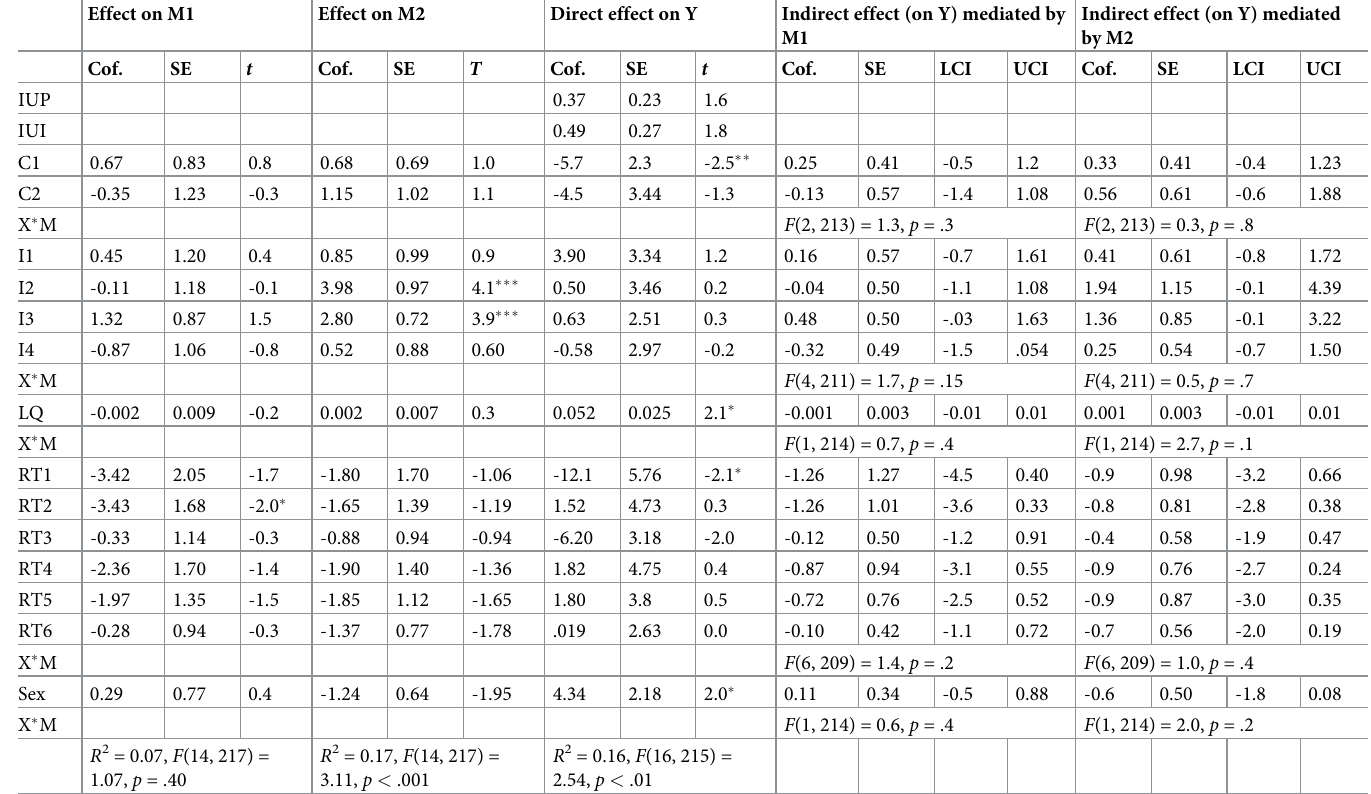
Table 12. The effects (direct and indirect effect) of antecedent and mediation (IUP & IUI) variables on religiousness in the community sample. Effect on